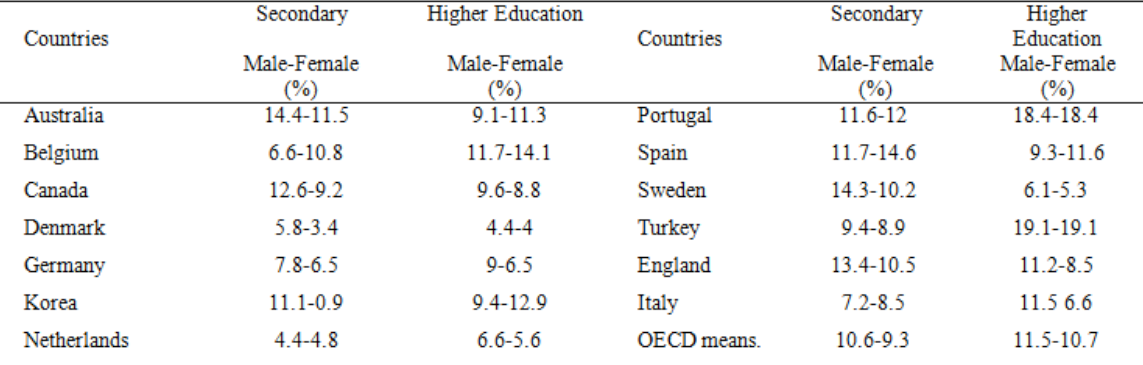
Table 1. Private return rates at different education levels in various countries